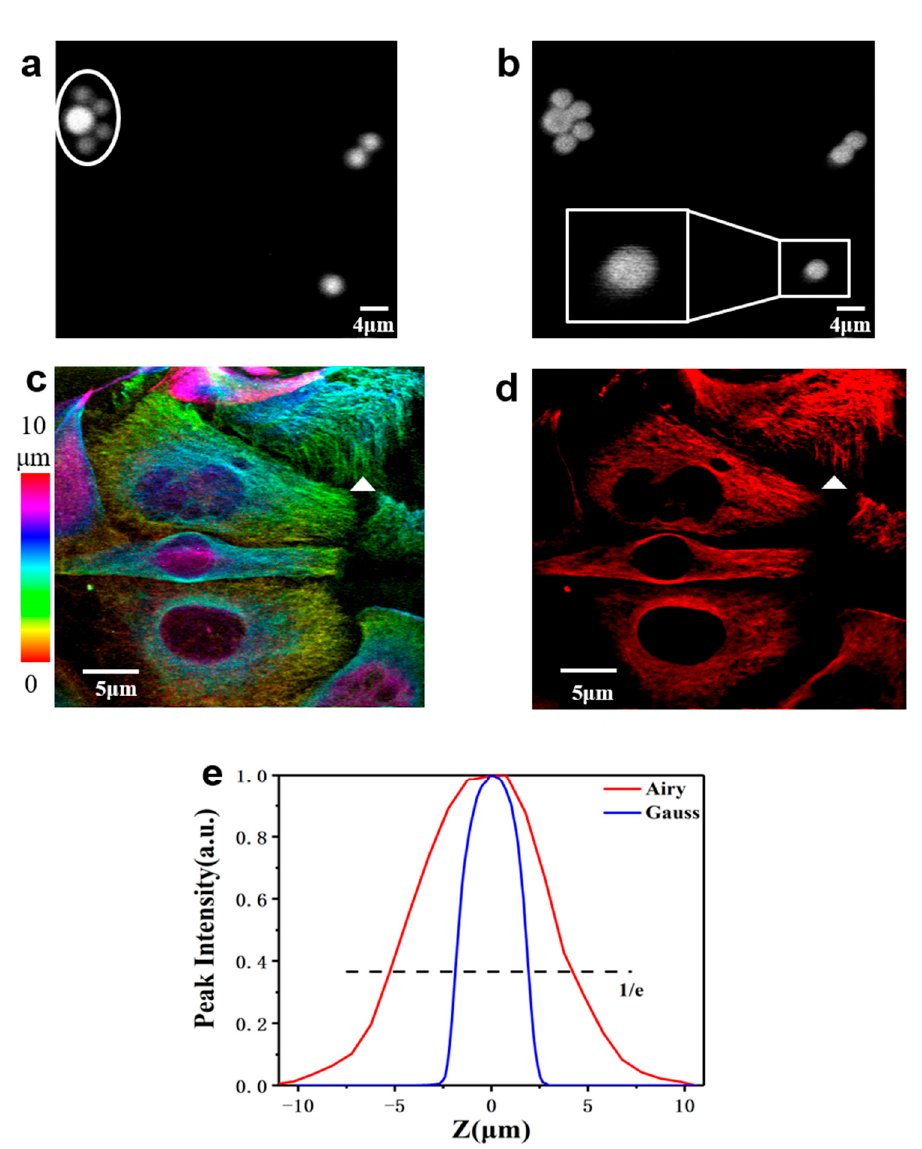
Figure 5. Volumetric imaging. ( a ) A single frame of fluorescent beads in the Gaussian mode. ( b ) Single frame of fluorescent beads in the Airy mode; ( c ) Projection of the Gaussian image stack of HeLa cell slice color-coded by depth; ( d ) Single frame of the HeLa cell in the Airy mode; ( e ) Peak signals of the fluorescent beads at different depths for the Airy beam (red curve) and the Gaussian beam (blue curve) microscopic imaging. Both signal intensities of the Airy beam and the Gaussian beam are normalized.